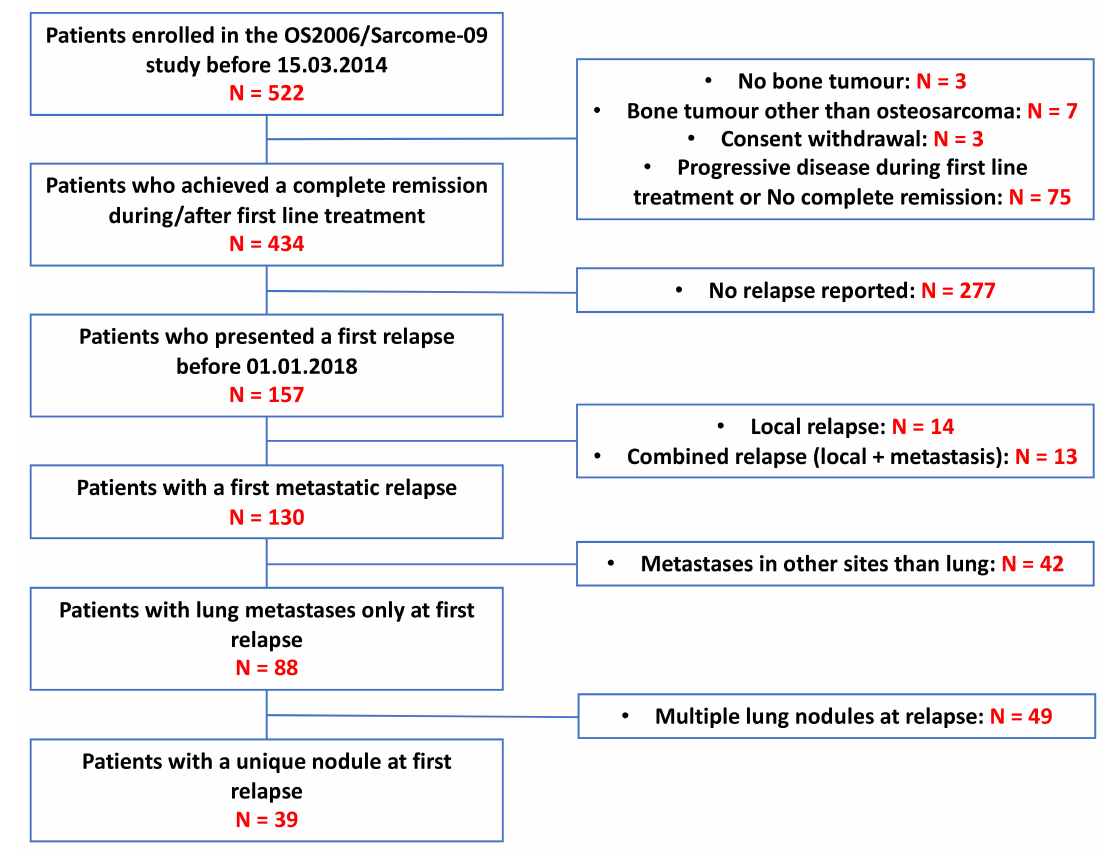
Figure 1. Participant flow of the current